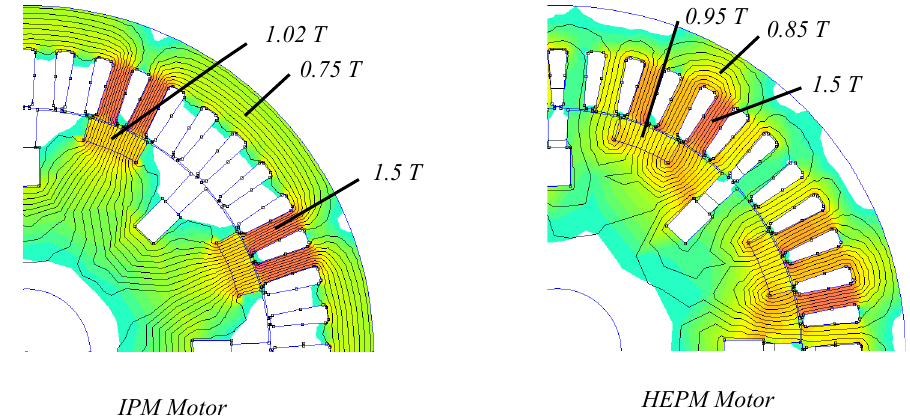
Figure 9. IPM and HEPM motor flux-density in FW at the end of FW